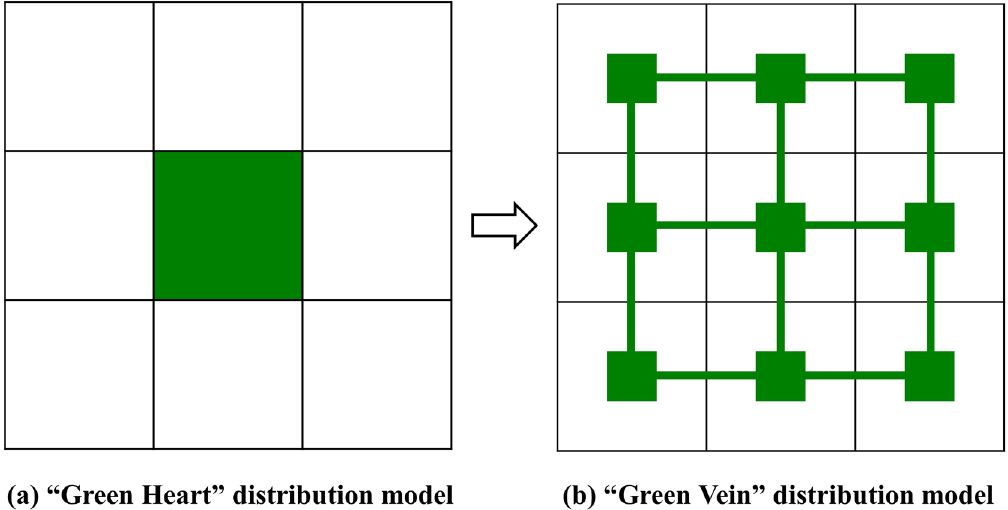
Figure 6. The evolution model of green space in urban built-up areas.